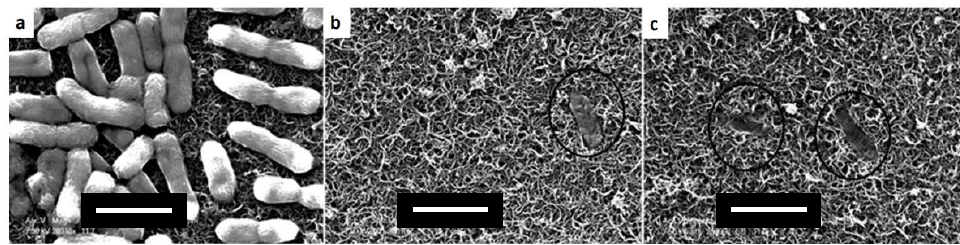
Figure 17. SEM images of membranes after detachment with: ( a ) no applied potential, ( b ) 1.5 V applied with membrane as anode, and ( c ) 1.5 V applied with membrane as cathode. Scale bars are 2 µ m. Reprinted from [120], with permission from American Chemical